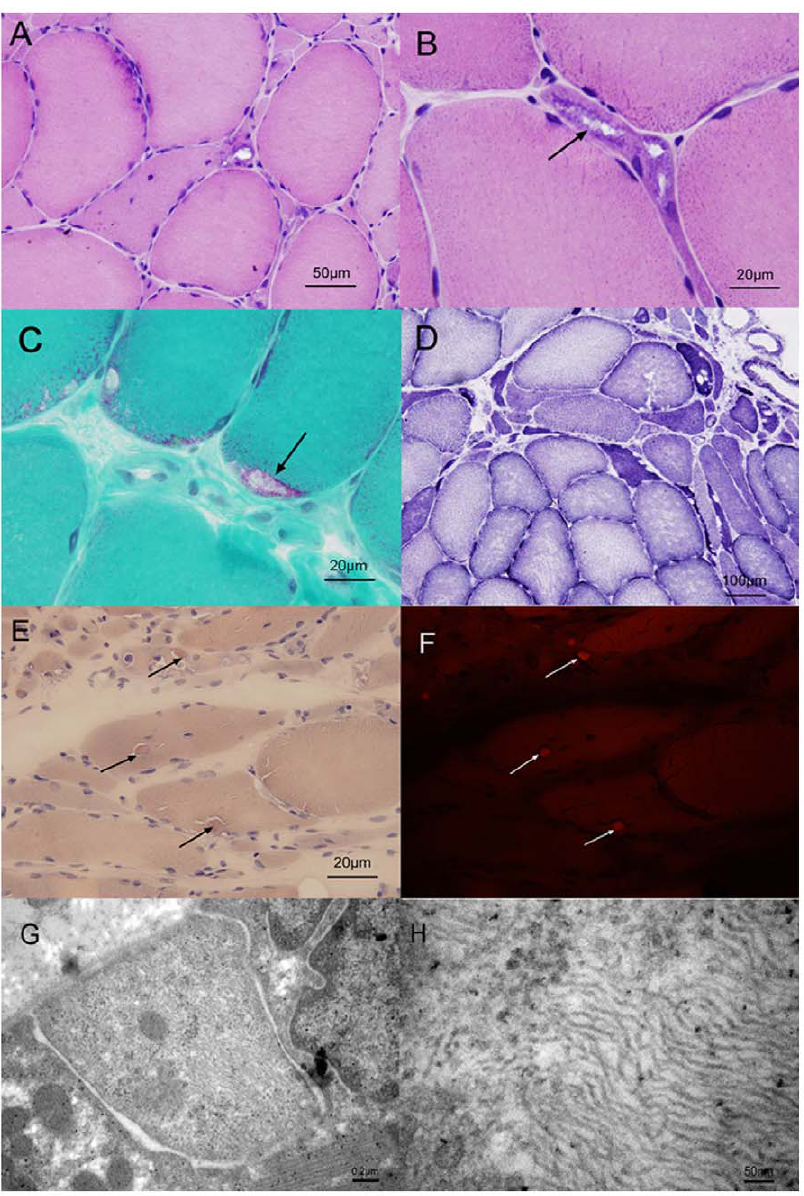
Figure 3. Serial sections of a muscle biopsy obtained from the left quadriceps femoris muscle of the index patient (patient III-1). A, Hematoxylin and eosin-stained cryostat section of muscle showing variations in fiber size and single or grouped atrophic fibers. B and C, Hematoxylin-eosin and modified Gomori trichrome stains demonstrating rimmed vacuoles (arrows). D, NADH dehydrogenase reacted section showing several fibers harbored focal decreases of enzyme activity. E and F, Congo red stained sections viewed under rhodamine optics showing small congophilic deposits in a few fibers (arrows). G and H, Electron micrograph showing cytoplasmic filamentous aggregates in a muscle fiber.